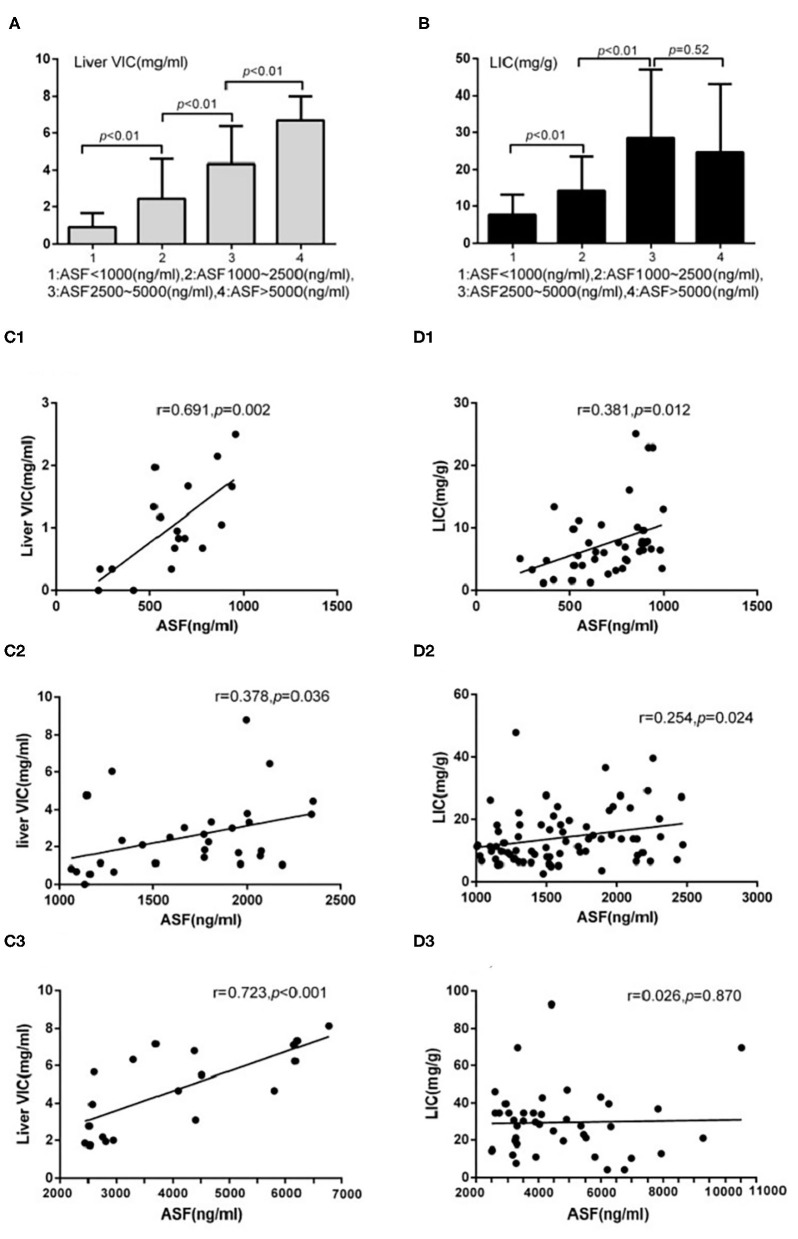
Underwent DECT/MRI examination: (A) Significant difference exists between the subgroups with ASF < 1,000 and 1,000 ≤ ASF < 2,500 subgroups in liver VIC expression (0.88 ± 0.77 vs. 2.44 ± 2.14, p < 0.05). Significant difference exists between the subgroups with 1,000 ≤ ASF < 2,500 and 2,500 ≤ ASF < 5,000 (2.44 ± 2.14 vs. 4.33 ± 2.04, p < 0.05). Significant difference between the subgroups with 2,500 ≤ ASF < 5,000 and 5,000 ≤ ASF subgroups (4.33 ± 2.04 vs. 6.69 ± 1.32, p < 0.05). (B) Significant difference exists between the subgroups with ASF < 1,000 and 1,000 ≤ ASF < 2,500 in LIC expression (7.60 ± 5.52 vs. 14.20 ± 9.17, p < 0.05). Significant difference exists between the subgroups with 1,000 ≤ ASF < 2,500 and 2,500 ≤ ASF < 5,000 in LIC expression (14.20 ± 9.17 vs. 28.45 ± 18.55, p < 0.05). No significant difference exists between the subgroups with 2,500 ≤ ASF < 5,000 and 5,000 ≤ ASF in LIC expressions (28.45 ± 18.55 vs. 24.46 ± 18.53, p < 0.05). (C1) There were significant correlation between Liver VIC and ASF in the subgroup with ASF < 1,000 ng/ml (r = 0.69, p < 0.05). (C2) There were significant correlation between Liver VIC and ASF in the subgroup with 1,000 ≤ ASF < 2,500 ng/ml subgroup (r = 0.38, p < 0.05). (C3) There were significant correlation between Liver VIC and ASF in the subgroup with 2,500 ng/ml ≤ ASF (r = 0.72, p < 0.05). (D1) There were significant correlation between LIC and ASF in the subgroup with ASF < 1,000 ng/ml (r = 0.38, p < 0.05). (D2) There were significant correlation between LIC and ASF in the subgroup with 1,000 ≤ ASF < 2,500 ng/ml (r = 0.25, p < 0.05). (D3) There were no significant correlation between LIC and ASF in the subgroup with 2,500 ng/ml ≤ ASF subgroup (r = 0.03, p > 0.05).